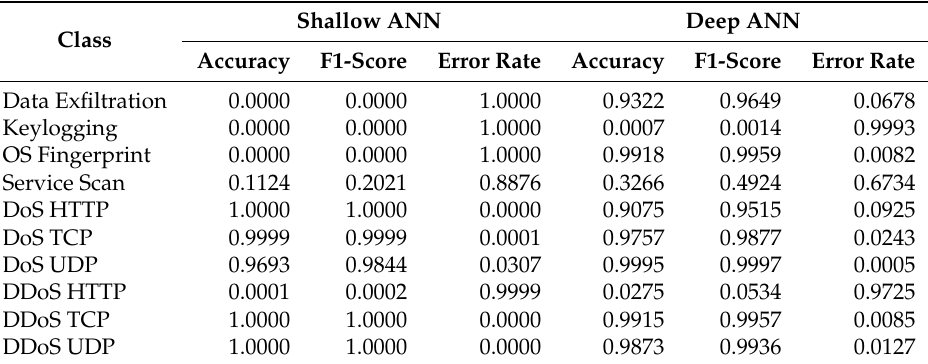
Table 10. Error rate for Type-B multi-class models using the Bot-IoT